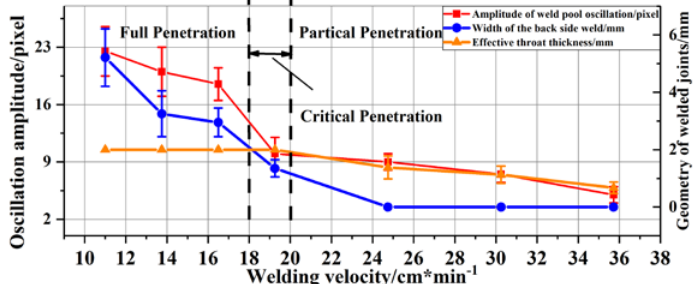
Figure 8. The amplitude of initial oscillation peak and geometry of the weld joints under different penetration status.